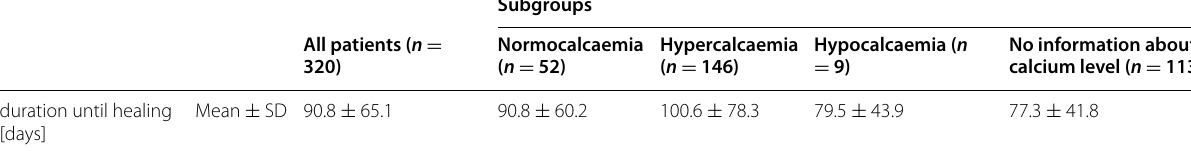
number of patients in whom it was =